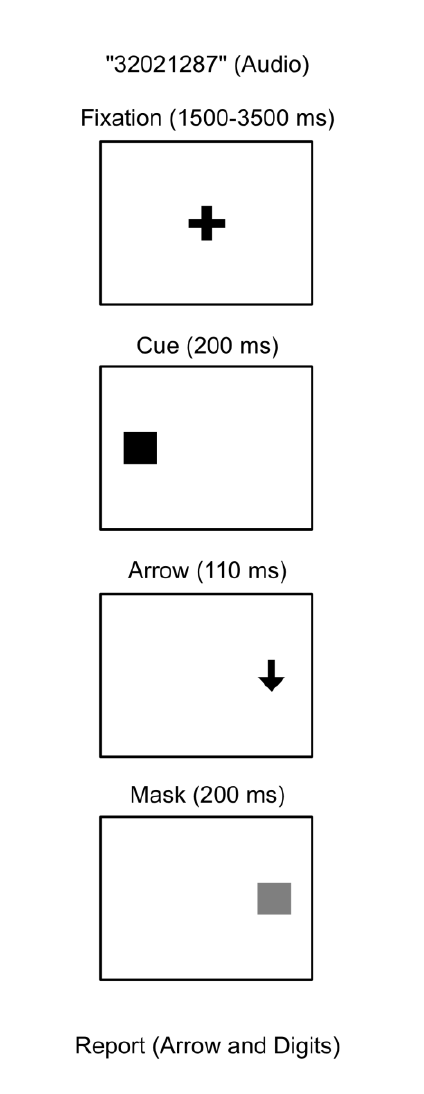
Figure 1. Sequence of sample visual and auditory stimuli for an anti-saccade trial. The location of the cue (left or right) and the direction of the arrow (up or down) were chosen ran- domly. For readability, the figures are not drawn to scale.